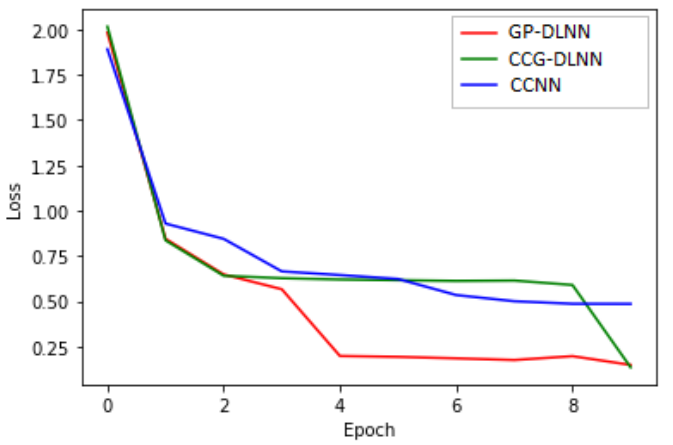
Figure 11. Curves of loss obtained by CCG-DLNN, GP-DLNN and CCNN on the LIDC-IDRI